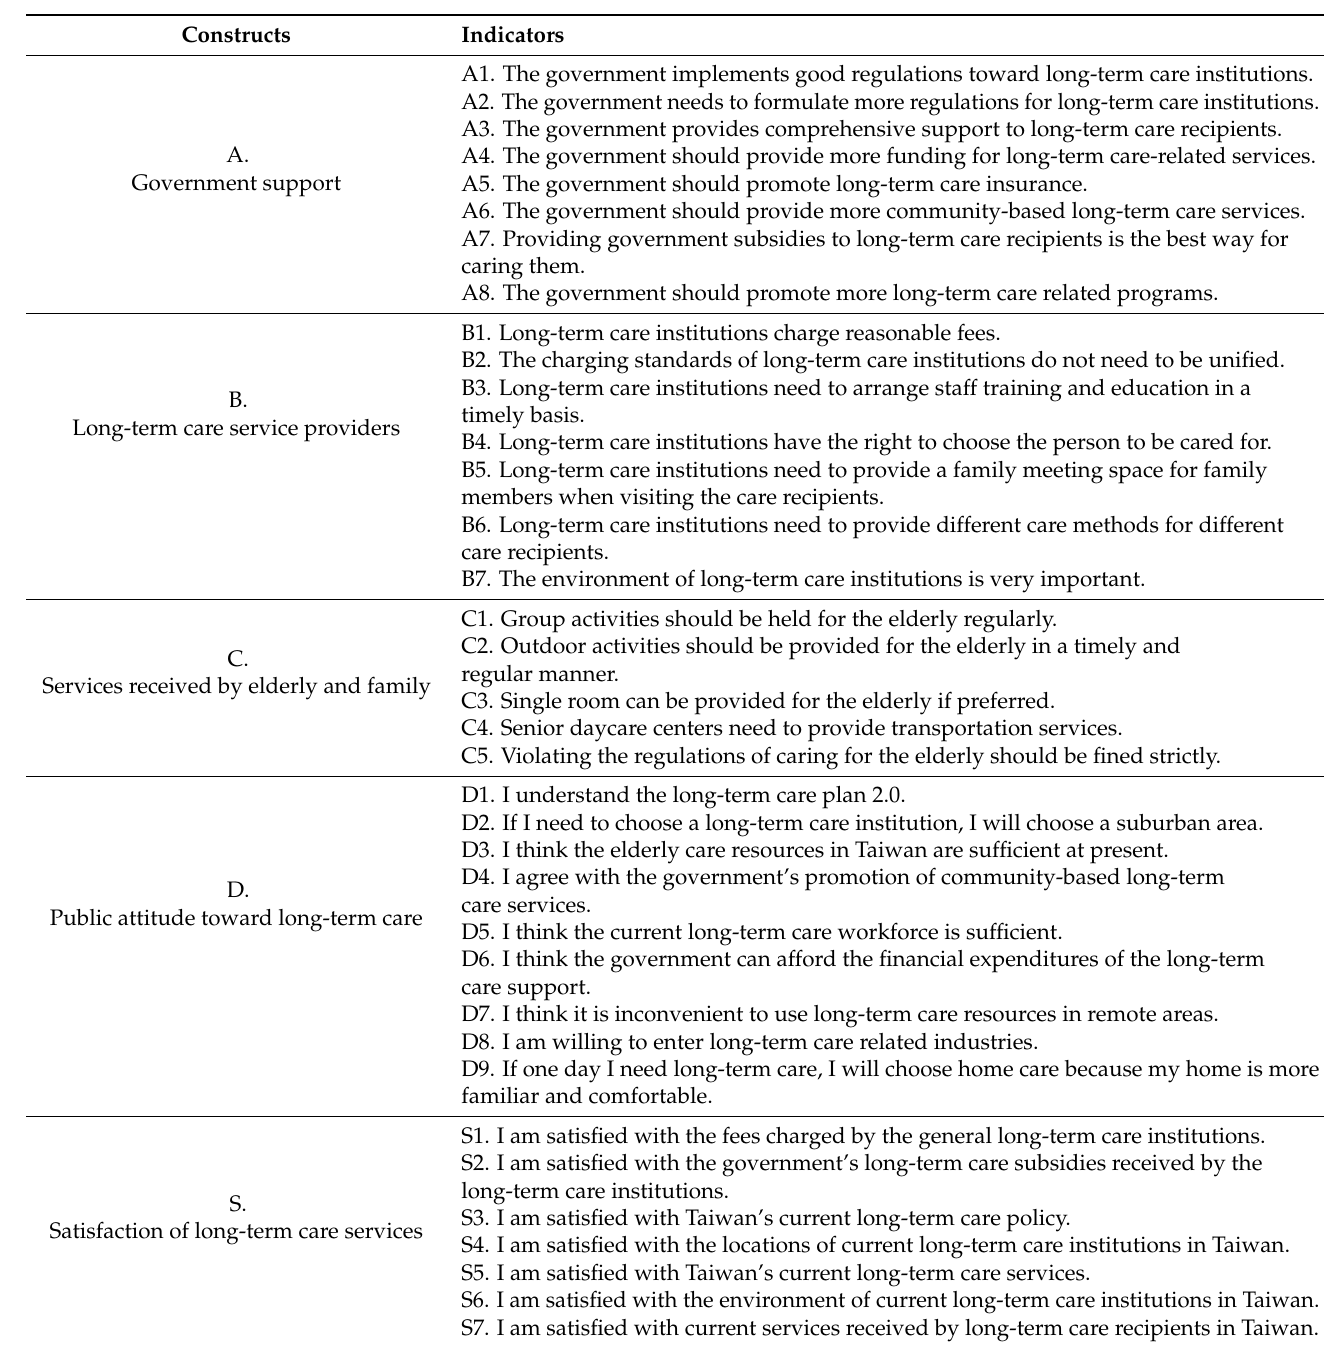
Table 1. Constructs and